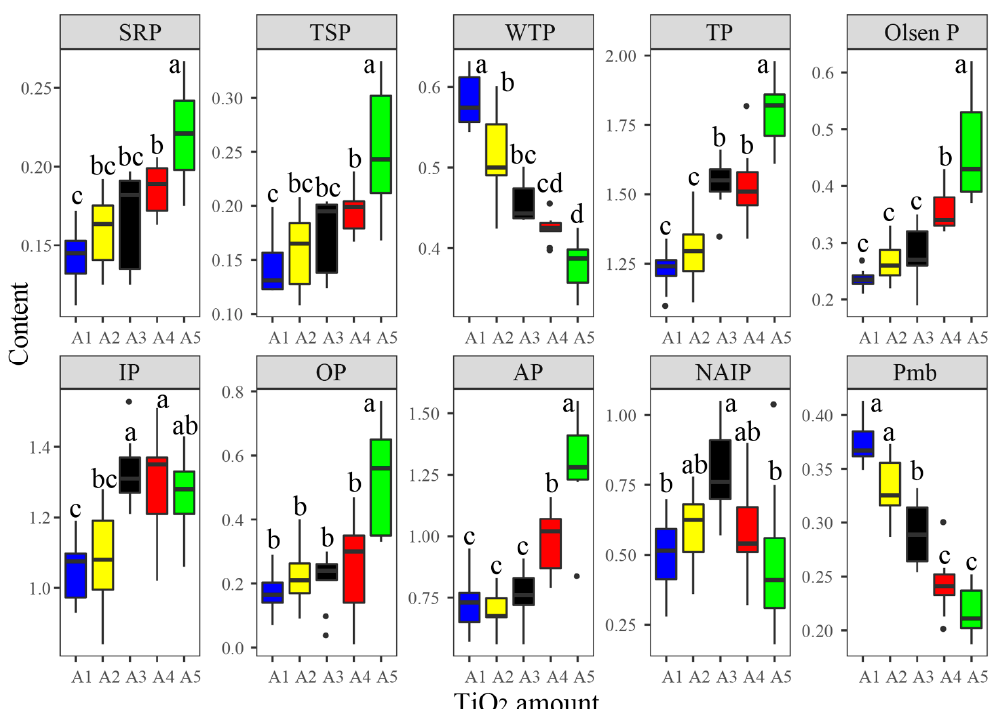
Figure 2. Differences in the content of phosphorus components among five groups with different TiO 2 NP addition amounts. Different letters above the columns denote significance ( p <